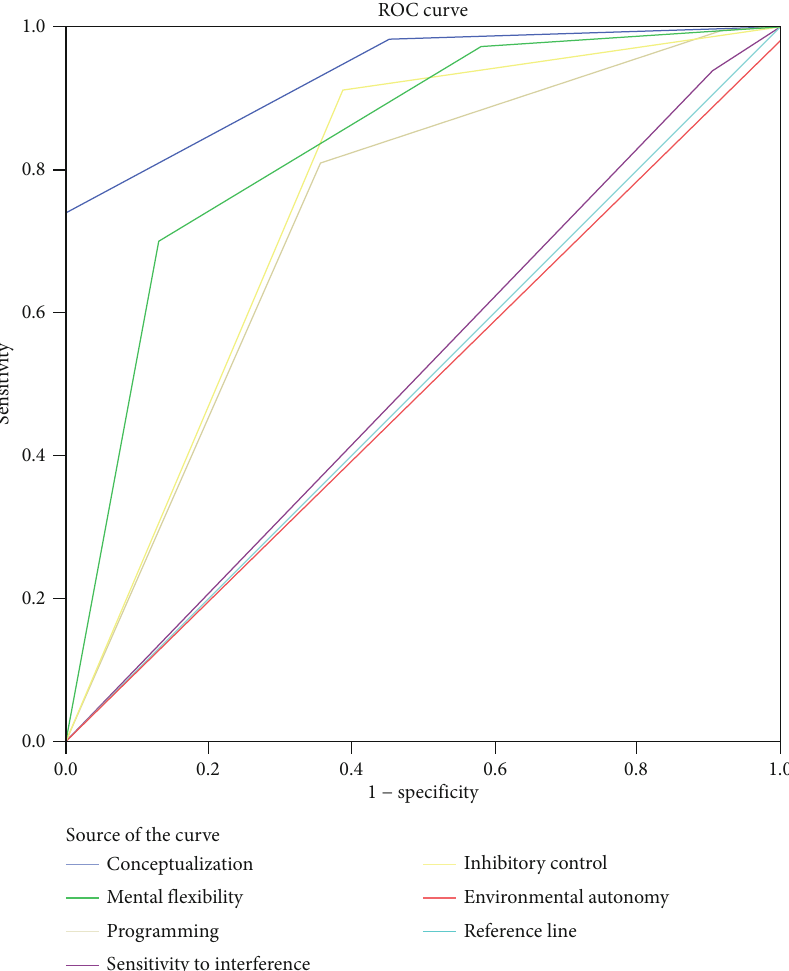
Figure 5: ROC curve discriminating between JME patients and HCs for FAB subset